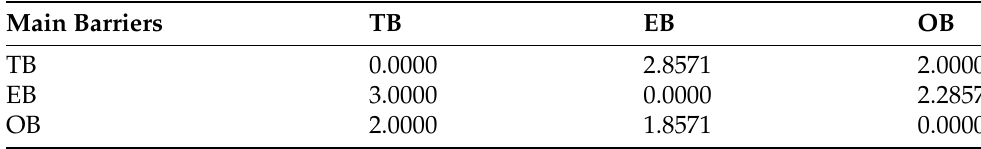
Table 10. Average direct-relation matrix (main barriers).